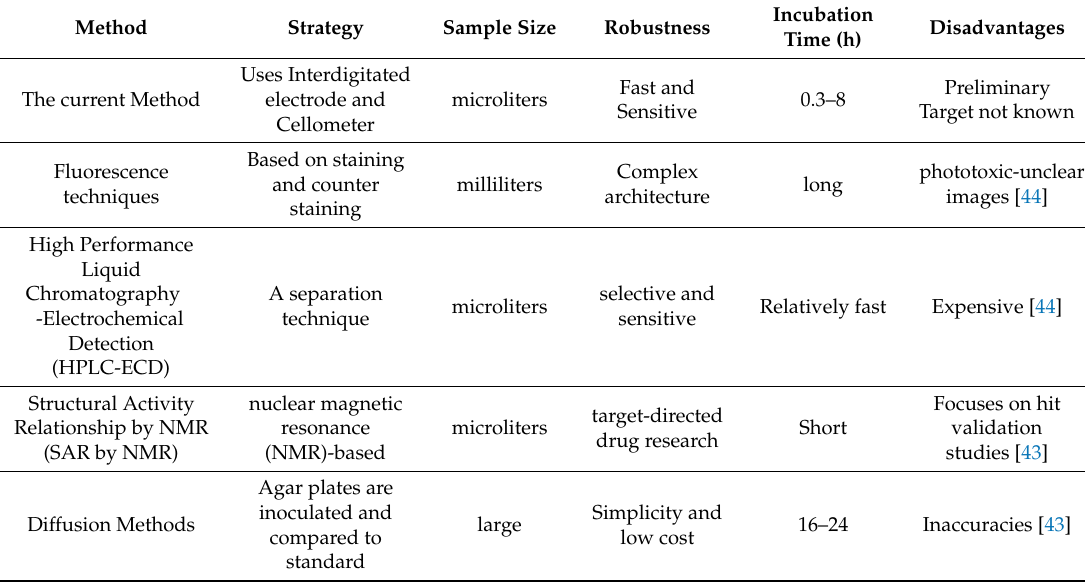
Table 1. Comparing the various methods for screening natural product activity towards molecular